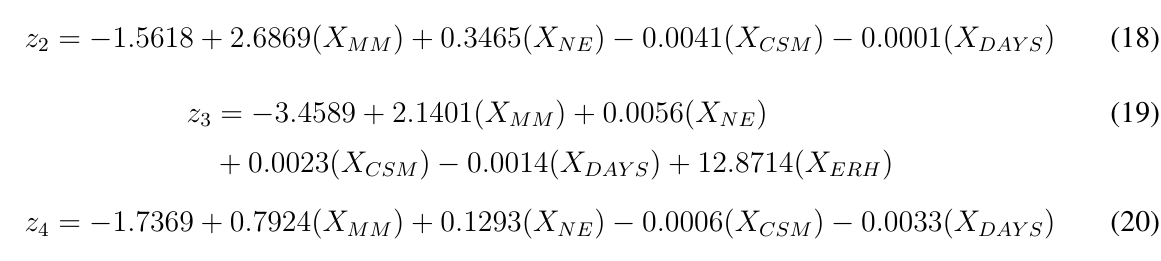
= 0 and X = 1 . The transition of X MM MM MM